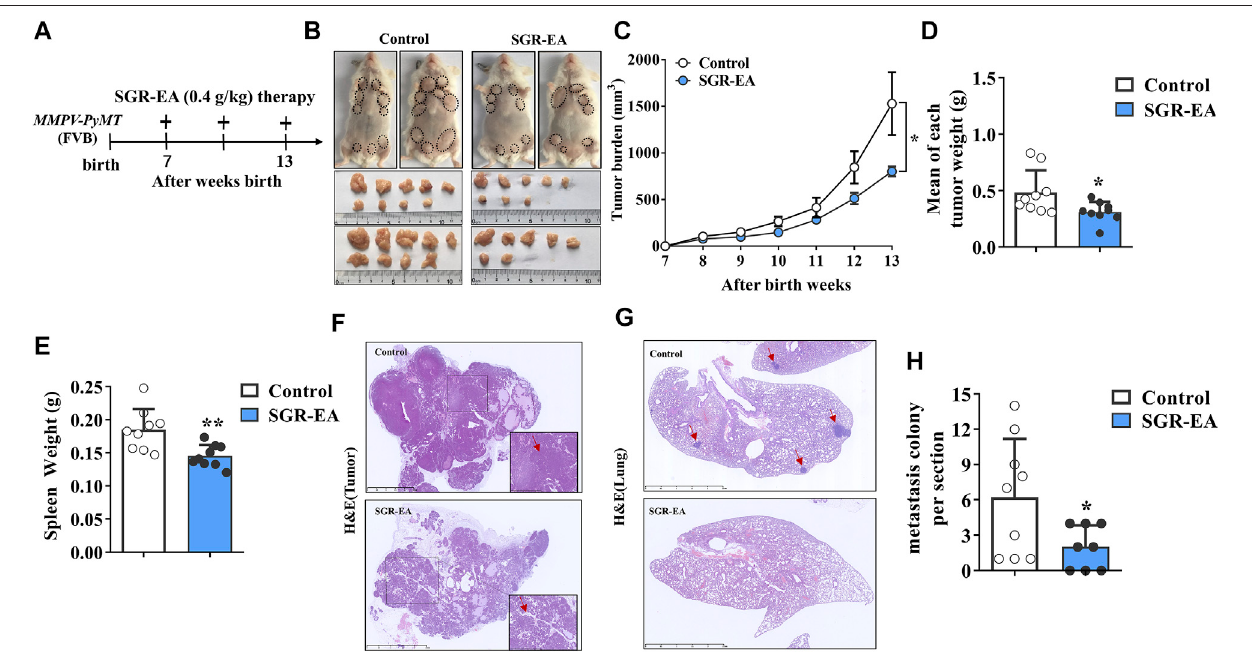
FIGURE 2 | SGR-EA therapy enhances the anti-cancer immune response in MMTV-PyMT mice. (A) Diagram depicting the treatment schedule and indicating the continuous daily administration of SGR-EA intragastrically from 7 weeks after birth. (B) Representative image showing the gross appearance of tumors. Dotted lines demarcate palpable breast tumor masses. (C) Comparison of the total tumor burden. (Tumor burden = the volume of tumor nodules in each mouse was added up.) (D, E) Comparison of the mean tumor and spleen weight. (Mean of each tumor weight = Mean weight of total tumor nodules per mouse.) (F) H and E – stained tumor sectionsshowingintratumoralregionswereviewedunderhighmagni fi cation(lowerrightpanel).Scalebars,2.5 mm. (G) LungsectionsstainedwithHandEwereviewed underhighmagni fi cation.Scalebars,2.5 mm;thepositionindicatedbytheredarrowisthelungmetastaticnodule. (H) Comparisonofthenumberofmetastaticcolonies ( > 100 μ m in diameter) per lung section. Unless otherwise denoted, n ≥ 8 for each group, and values are mean ± SD. * p < 0.05 and ** p < 0.01 versus